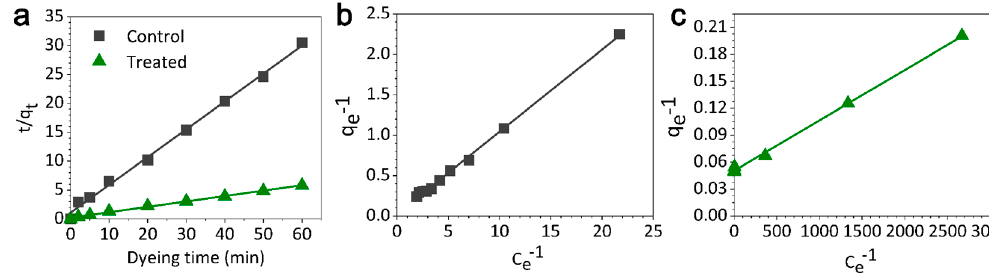
Figure 4. ( a ) Fitted curves of SCC on untreated control and treated cotton fabrics with the pseudo-second-order model, and Langmuir adsorption isotherms of SCC on the ( b ) untreated control and ( c ) pre-treated fabric.